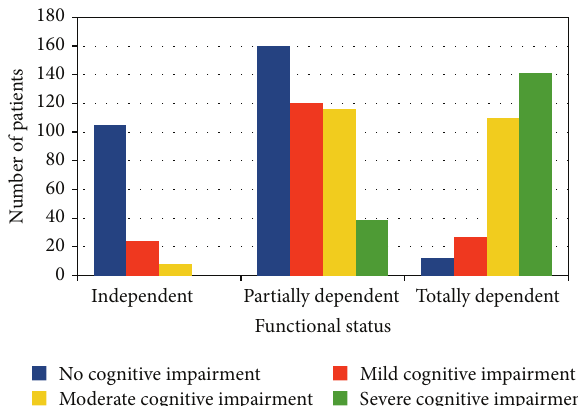
Figure 1: Distribution of cognitive impairment according to func- tional class among older diabetic